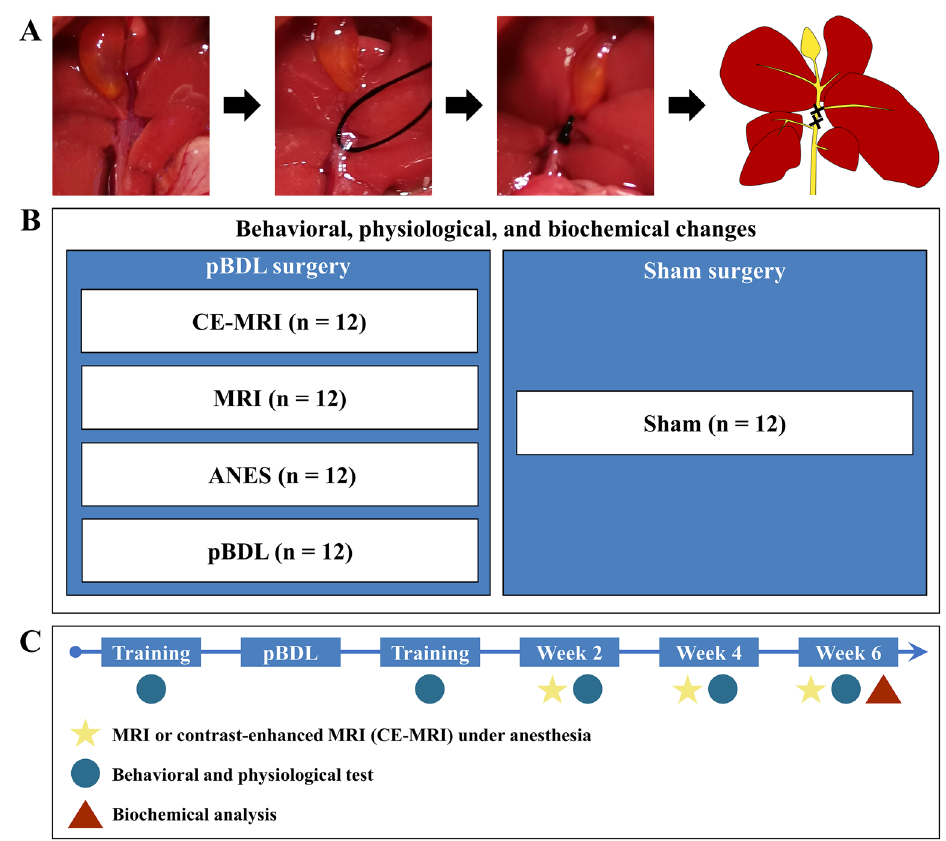
Figure 1. ( A ) Surgical photographs and ligated location demonstrating the technique for pBDL. ( B ) Overview of the experimental groups. ( C ) Timeline of the animal experimental procedure. Sham, only suture the abdominal wall. pBDL, partial bile duct ligation surgery alone; ANES, repeated anesthesia in the pBDL model; MRI, repeated magnetic resonance imaging under anesthesia in the pBDL model; CE-MRI, repeated